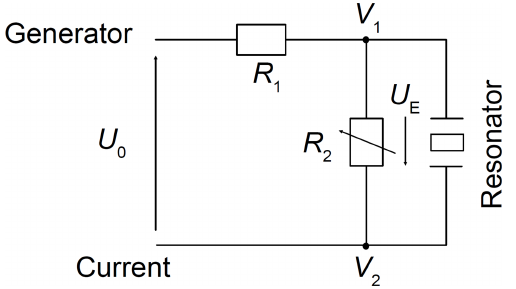
Figure 4. Electrical circuit to excite TSM vibrations with low volt- ages (µV to mV) and to evaluate the impedance spectra in the vicinity of the resonance of a 5MHz CTGS resonator. A Solartron SI 1260 impedance/gain-phase analyser is used for the electrical ex- citation and the impedance